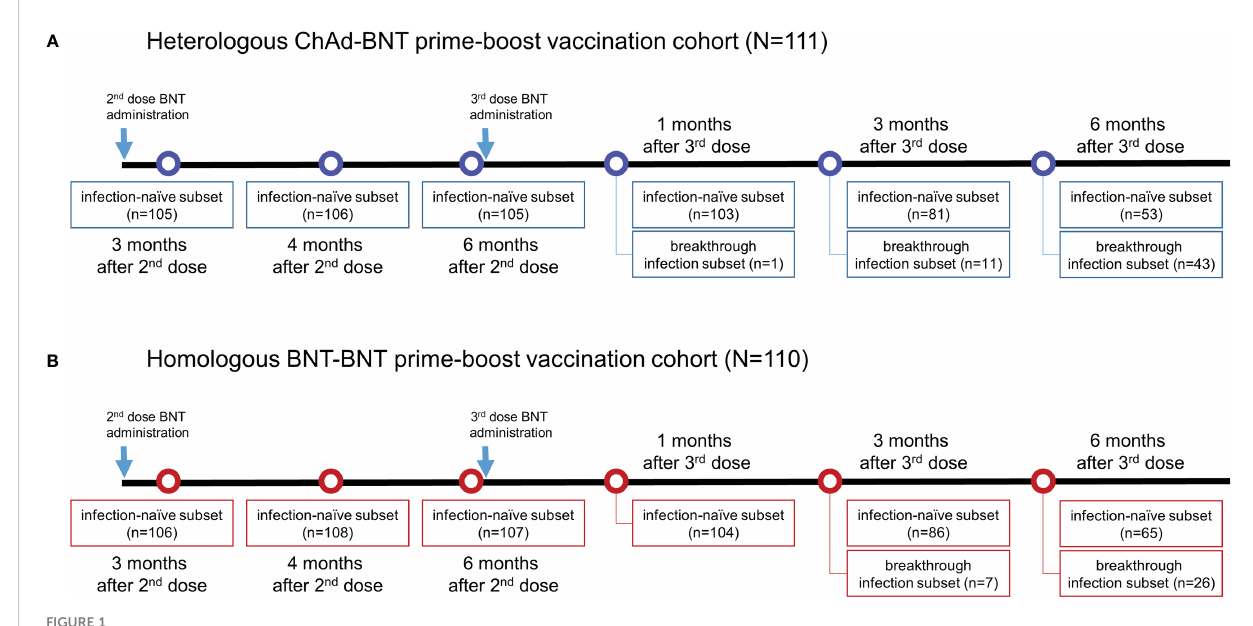
FIGURE 1 Overall timeline of sampling and the number of participants in ChAd-primed (A) and BNT-primed (B) vaccination cohorts. N, total number of participants in each cohort; n, number of participants who underwent blood sampling during the speci fi ed